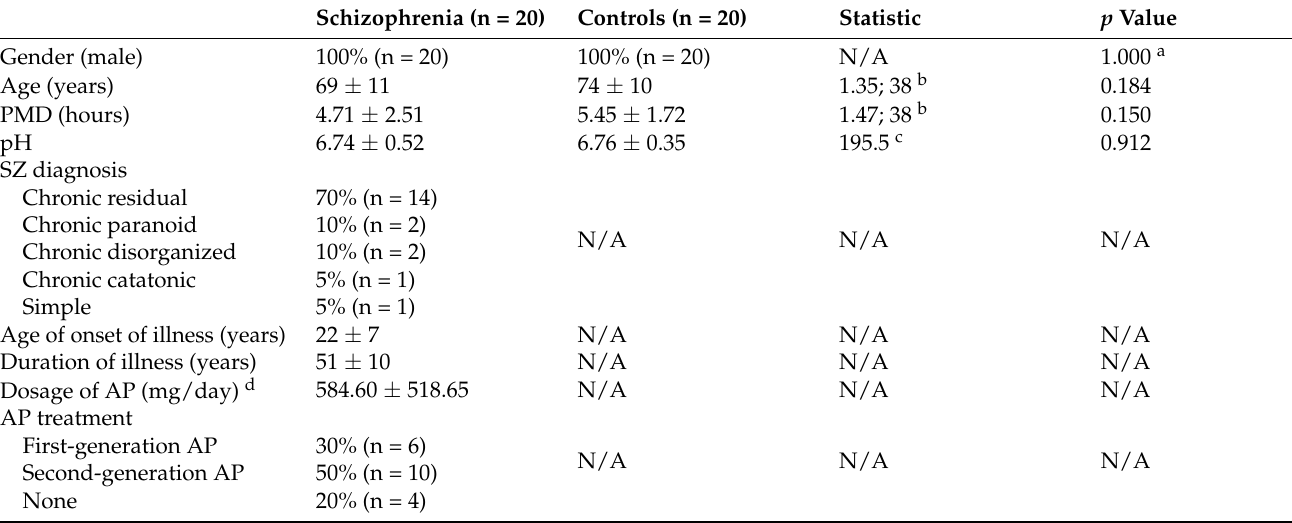
Table 1. Demographic-, clinical-, and tissue-related features of cases in the whole cohort (n = 40). Schizophrenia (n =